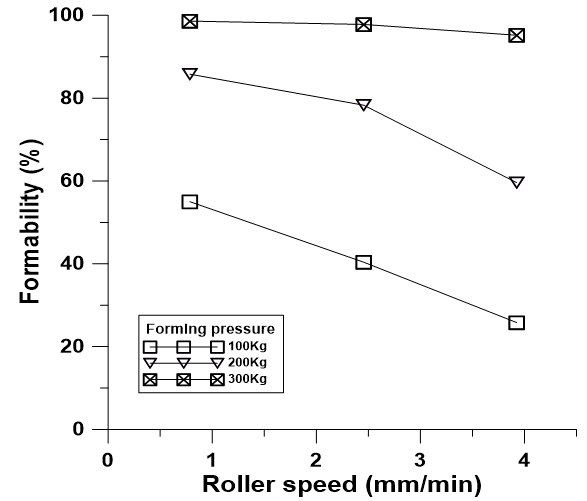
Figure 10. E ff ect of formability by unequal forming pressure and roller speed of composite belt-type PDMS microstructure soft mold.